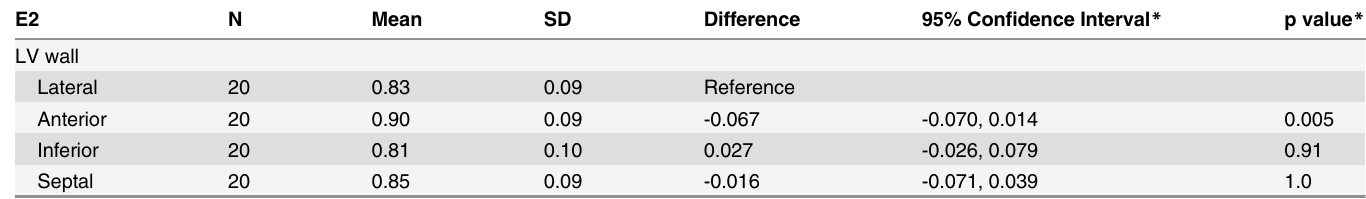
Table 4. E2 Regional Analysis (×10 -3 mm 2 s -1 ). Lateral wall used as the reference for statistical comparisons.